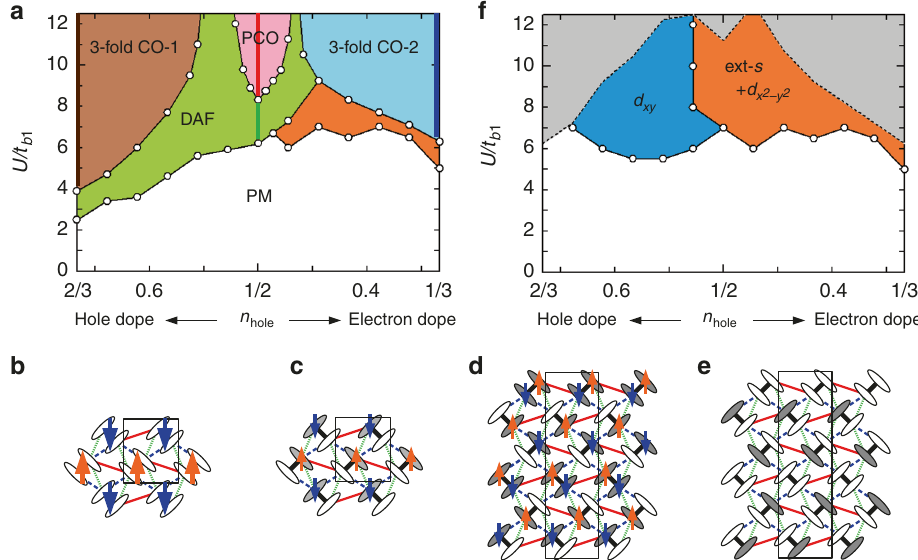
Fig. 2 Ground-state phase diagram. a Ground-state phase diagram of the EHM for κ -(ET) 2 X. DAF, PCO, 3-fold CO-1, and 3-fold CO-2 phases are insulating only along vertical bold lines and metallic for other colored regions. b – e Schematic view of each symmetry-broken phase: ( b ) DAF, ( c ) PCO, ( d ) 3-fold CO-1 (magnetic), and ( e ) 3-fold CO-2 (nonmagnetic). Up (down) arrows represent up (down) spin-rich molecular sites. Solid (open) ovals represent hole-rich (hole-poor) molecular sites. The black rectangles are unit cells. f Ground-state phase diagram for SC, ignoring other ordered phases. The gray regions indicate where the strong intersite Coulomb interactions strongly suppress the hole mobility (see the